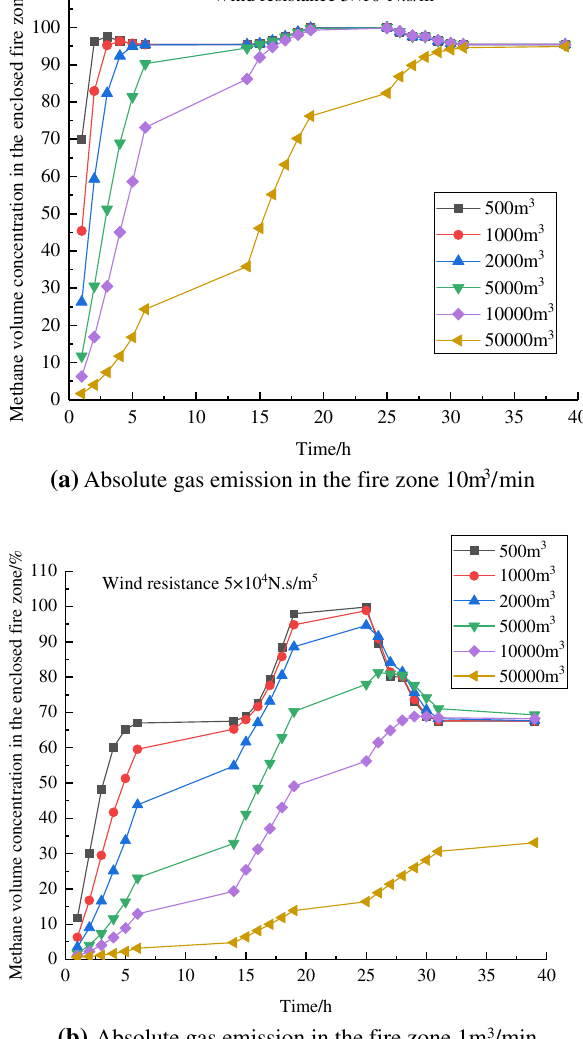
(b) Absolute gas emission in the fire zone 1m 3 /min Fig. 14 Different gas emission, different fire zone volume, and large wind resistance, the changes of gas concentration in the fire zone with time after the completion of sealing at